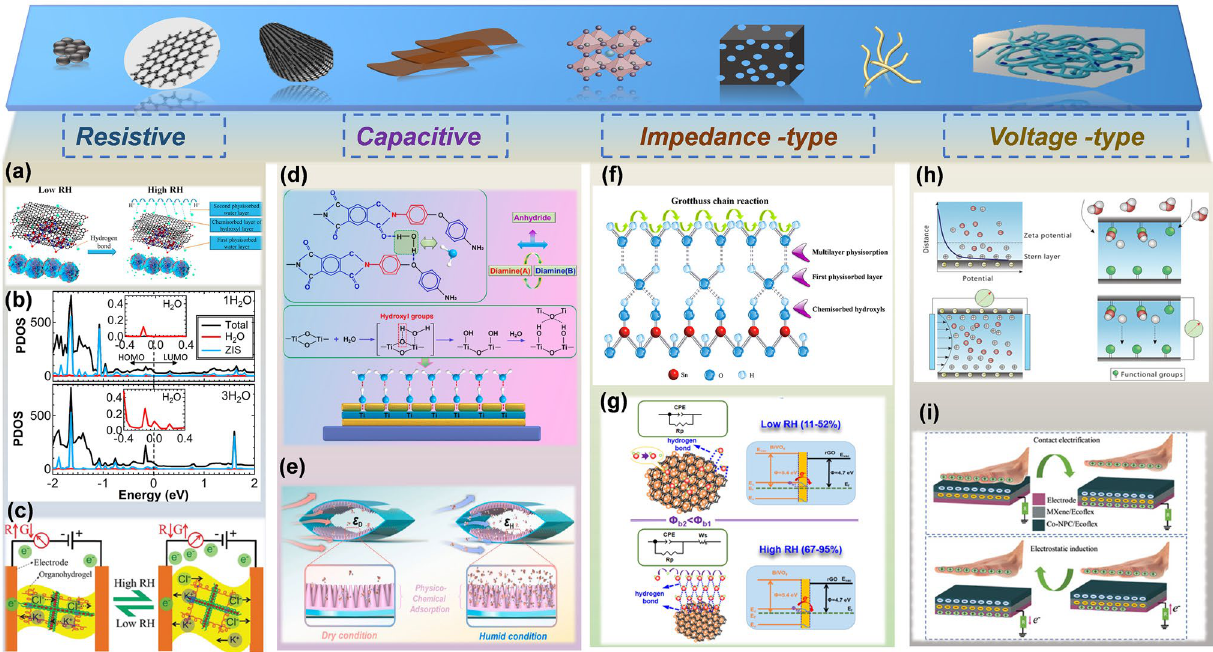
Fig. 2 The working principle of flexible humidity sensor at low and high RH. ( a ) The adsorption of water molecules on the SnS 2 /RGO compos- ite film at low and high RH [70]. Copyright 2019 Elsevier. ( b ) 1H 2 O and 3H 2 O at a bias of 3.3 V [44]. Copyright 2020 ACS Publications. ( c ) Schematic illustrating the humidity sensing principle of the organohydrogel [71]. Copyright 2019 Royal Society of Chemistry. ( d ) Illustration of the humidity sensing process of the water molecule adsorption [73]. Copyright 2021 Elsevier. ( e) Schematic of the proposed flexible capacitive humidity sensing system based on arc-shaped hollow structure for monitoring human physiological signals [74]. Copyright 2021 Elsevier. ( f) Schematic of adsorption of water layers on the SnO 2 surface [79]. Copyright 2016 Elsevier. ( g ) Schematic diagram of the sensing